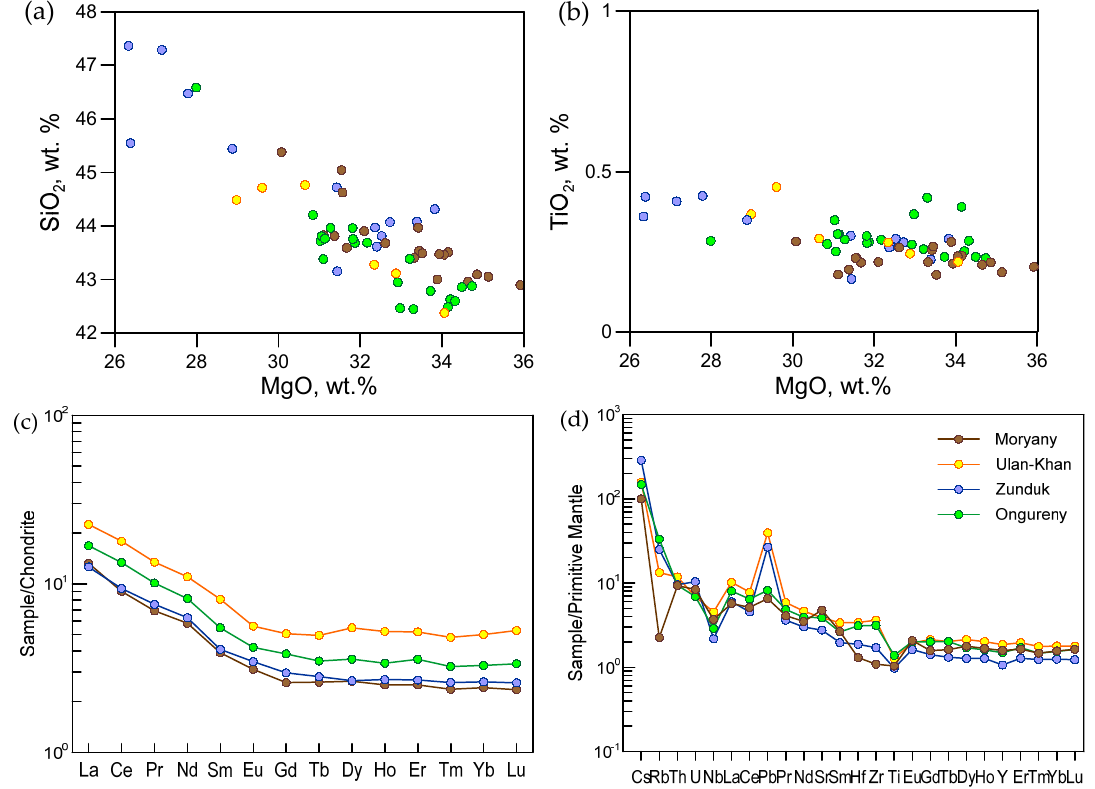
Figure 4. ( a ) SiO 2 and ( b ) MgO vs. TiO 2 plots. The major-element oxides were recalculated to 100% on a volatile-free base; ( c ) Chondrite-normalized [32] rare earth element (REE) and ( d ) Primitive Mantle- normalized [33] trace element abundance patterns for ultramafic rocks of the Primorsky Ridge.